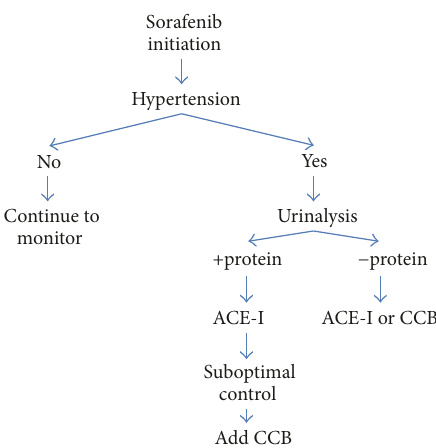
Figure 6: Algorithm for treatment of sorafenib-induced